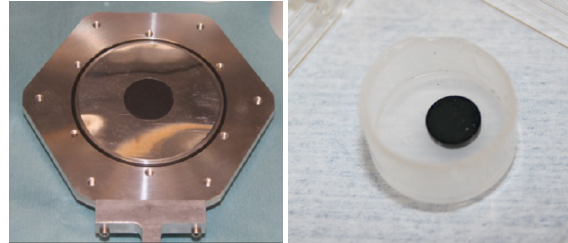
Fig. 5. Left part: 233 U disc with a diameter of 30 mm and thickness of 0.64 mm prepared by punching and mounted in a measurement holder with 50 µm Al foil. Right part: Picture of a 5 mm diameter pellet of 0.1 g 238 U 3 O 8 in a plastic container.